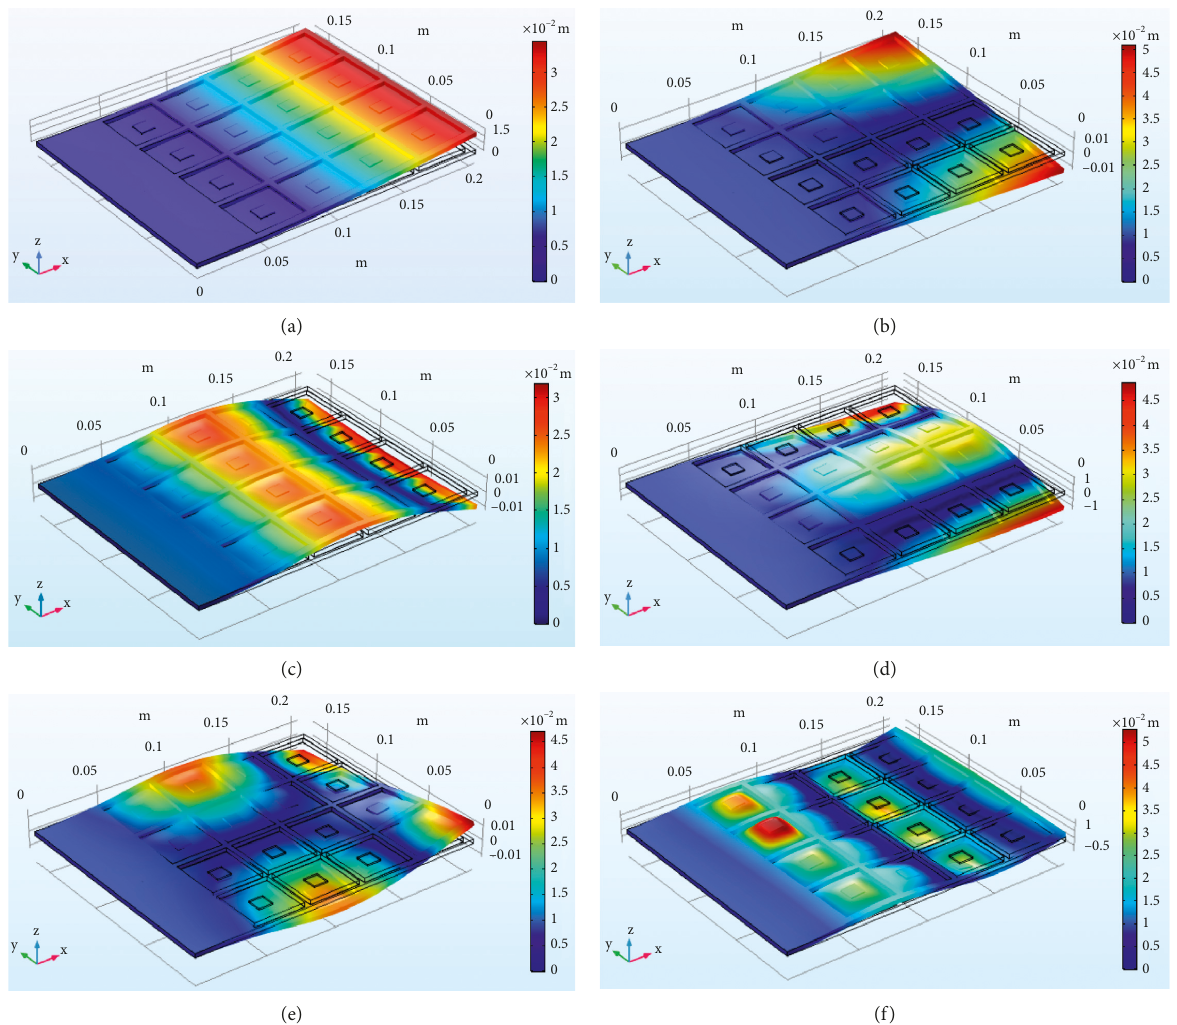
Figure 17: First six vibration mode shapes. (a) First. (b) Second. (c) Third. (d) Fourth. (e) Fifth. (f)